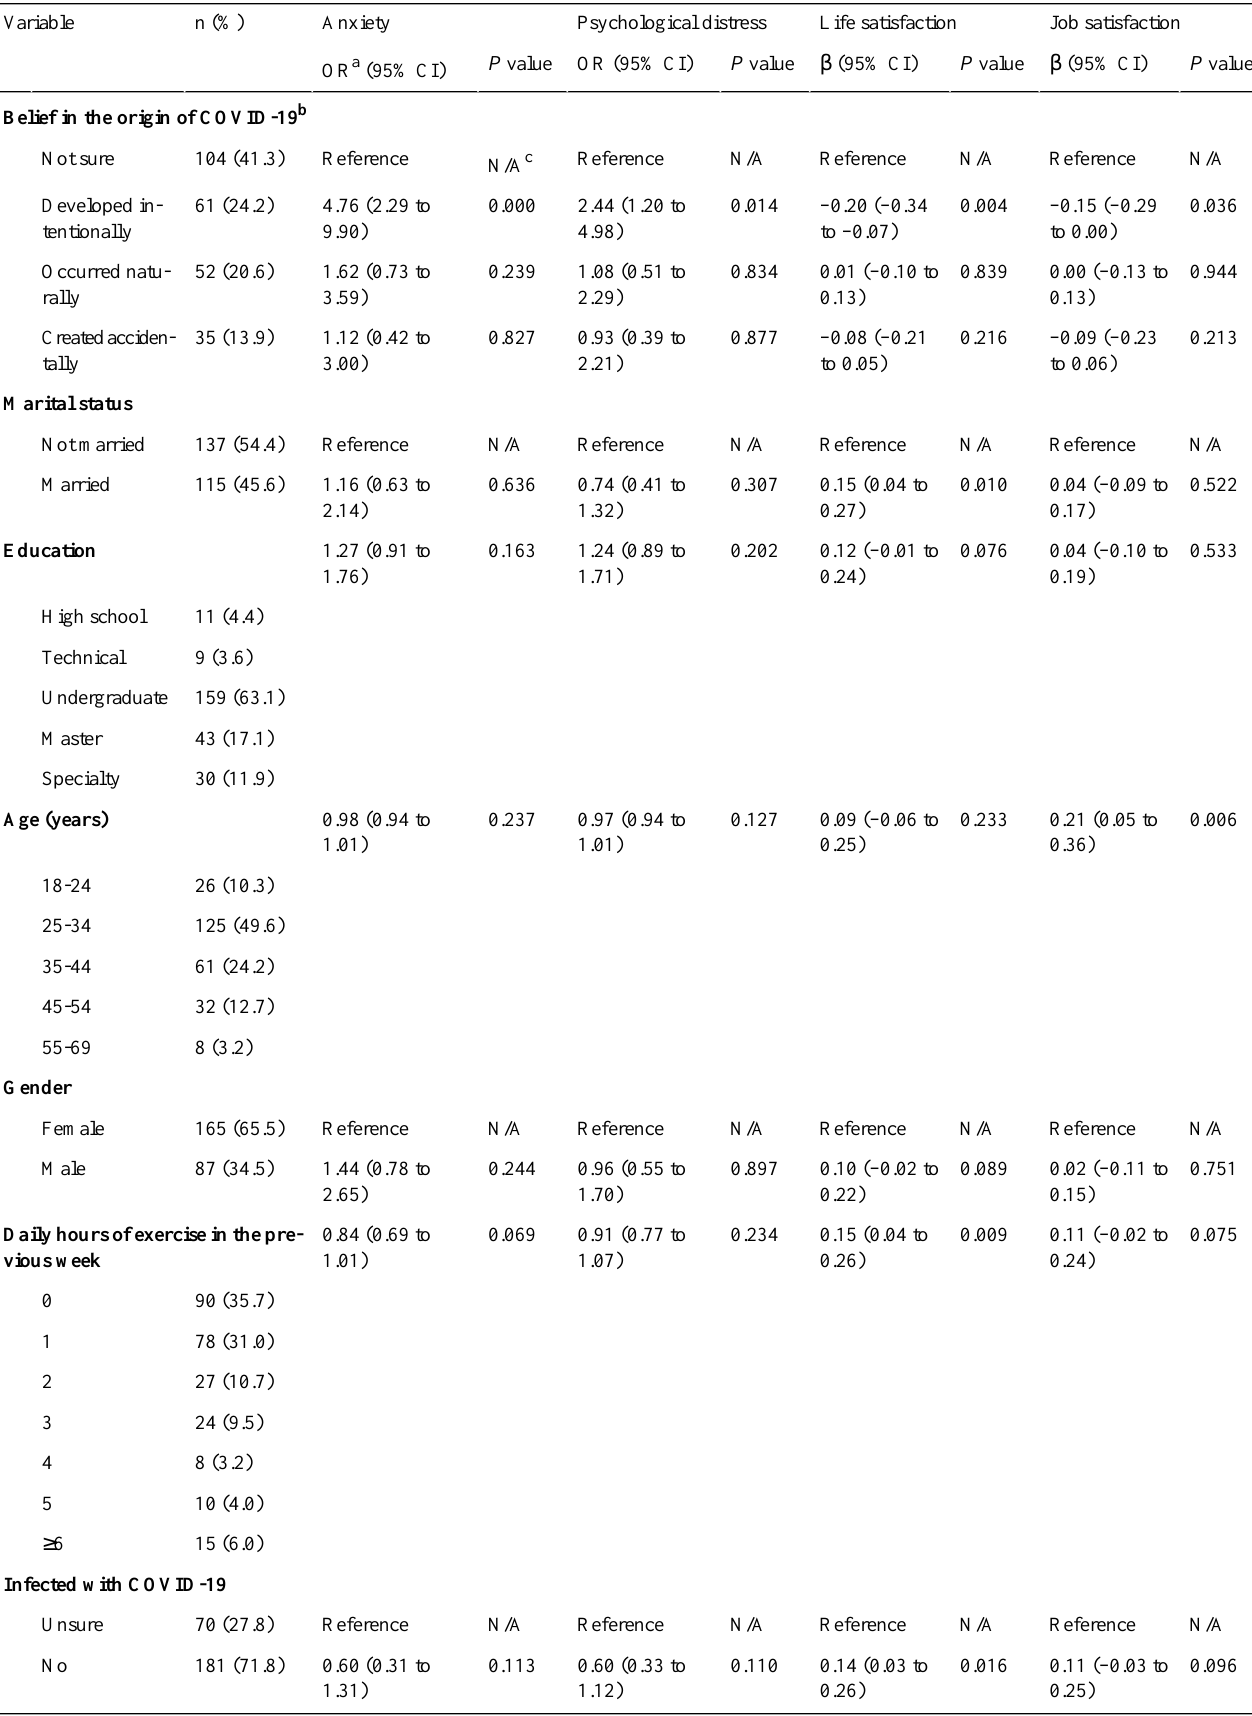
Table 1. Descriptive findings and predictors of health care workers’mental health and well-being by regression analyses (N=252).